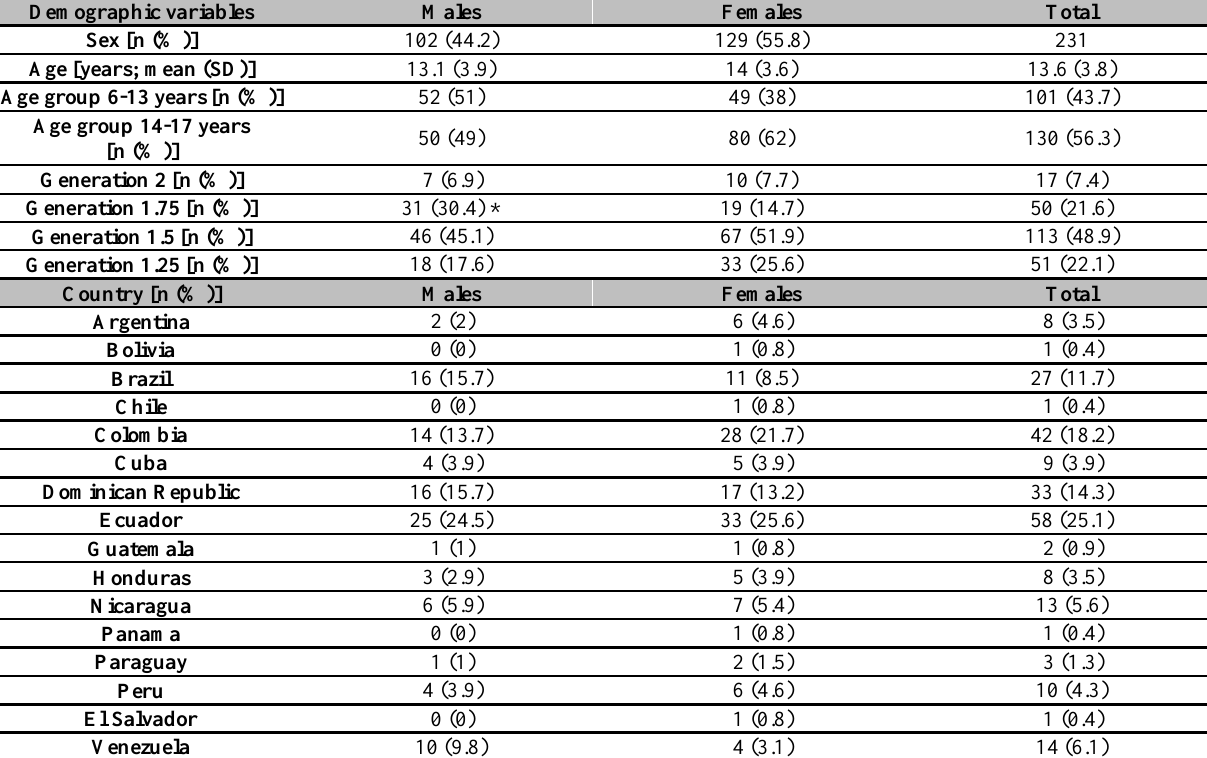
Table 1. Demographic variables and countries of origin of 231 Latin American children in the child protection system of Aragon (Spain) Demographic